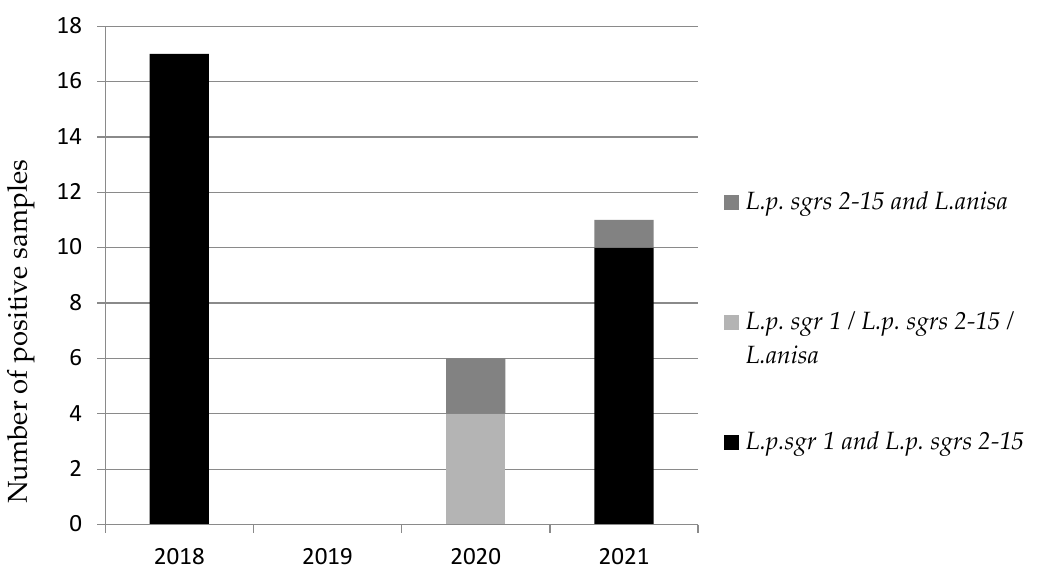
Figure 3. Number of samples with presence of co-isolates during the four-year surveillance program, regarding different L. pneumophila (L.p.) sgrs and L. anisa.